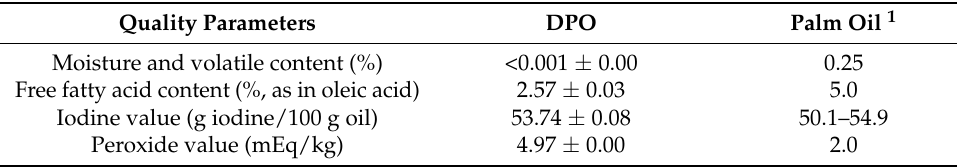
Table 2. Quality parameters of DPO and palm